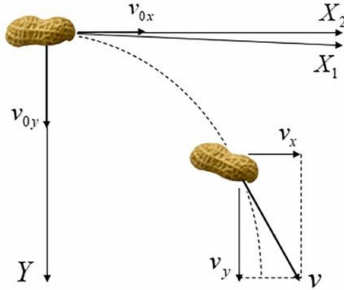
Figure 6. The movement track after pod separation process. v 0x is the initial horizontal velocity of the peanut pod after it has detached from the root, m/s; v 0y is the initial vertical velocity of the peanut pod after it breaks away from the roots, m/s; v x is the horizontal velocity of the peanut pods after they have detached from the roots, m/s; v y is the vertical velocity of the peanut pod after it has detached from the root, m/s. v is the rate of synthesis of peanut pods after detachment from the roots.